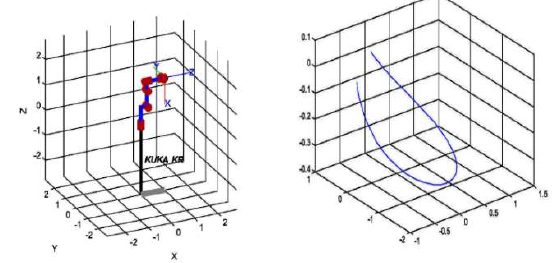
Figure 3. Simulation of two